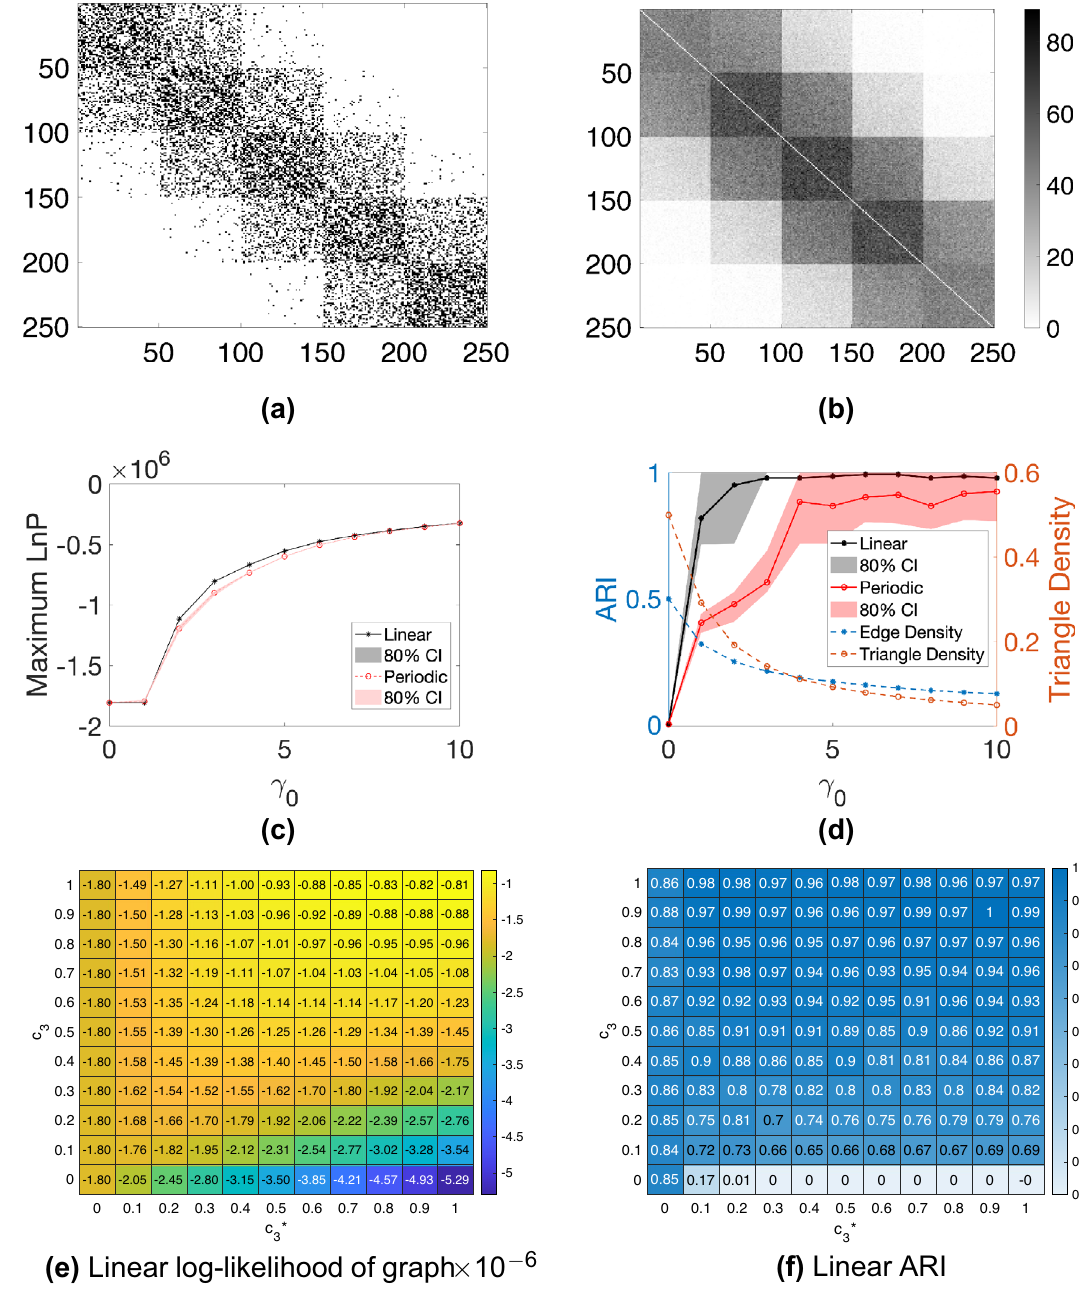
Figure 1. Model comparison experiments on synthetic linear hypergraphs. ( a ) Black pixels in the dyadic 4 ) represent edges, and they reveal 5 clusters in the diagonal blocks. ( b ) In the adjacency matrix ( γ 0 = 4 ). ( c ) The linear triadic adjacency matrix, colors reflect the number of triangles shared between nodes ( γ 0 = embedding achieves higher log-likelihoods than the periodic version for hypergraphs generated with different γ 0 . ( d ) Adjusted Rand Indices of K-means clustering based on the linear and periodic embedding are plotted 6 10 against γ 0 . ( e ) Values in the heatmap represent the maximum likelihoods of the linear model from − × c 3 . ( f ) Values represent the Adjusted Rand Algorithm 3. The maxima are found along the diagonal when c ∗ 3 = Indices of K-means clustering based on the linear embedding for different values of c ∗ 3 and c 3